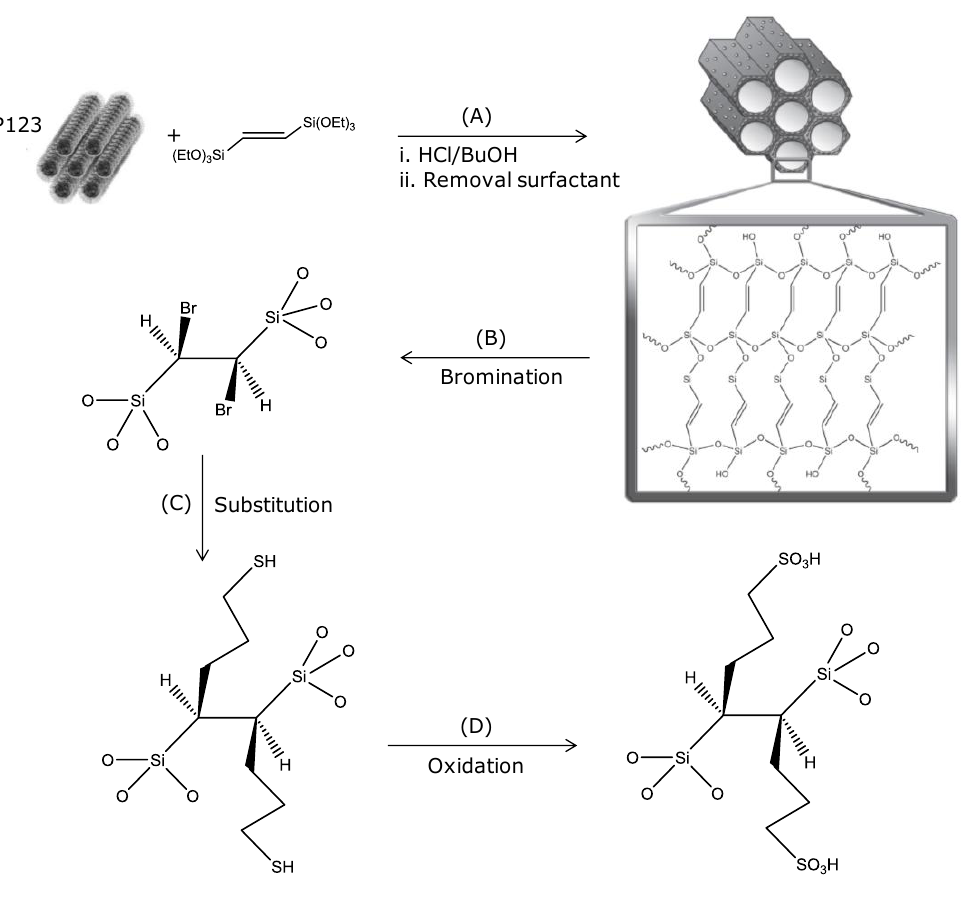
Figure 1. Summary of the synthetic pathways followed in this study. ( A ) Preparation of trans -ethenylene bridged Periodic Mesoporous Organosilica [EP]; ( B ) Bromination of EP [BEP]; ( C ) Substitution of the bromine with Grignard reagent of